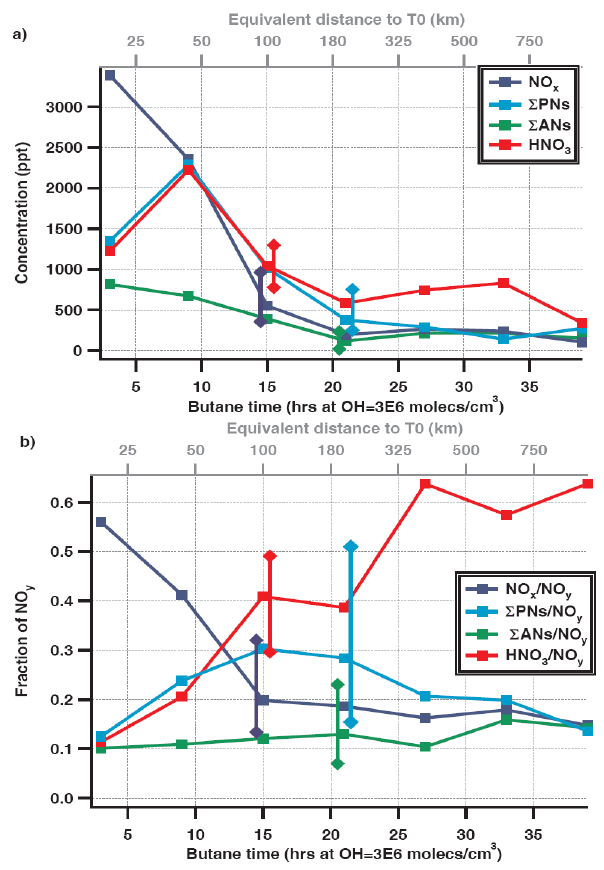
Figure 4a) Observed concentrations of the components of NO y as a function of 708 Fig. 4. (a) Observed concentrations of the components of NO y as a function of photochemical age. Error bars show the 1 σ variation photochemical age. Error bars show the 1 σ variation in the data. 4b) Observed fraction of 709 in the data. (b) Observed fraction of NO y comprised of each of the NO y comprised of each of the NO y reservoirs as a function of photochemical age. Again, 710 NO y reservoirs as a function of photochemical age. Again, error error bars show the variation at 1 σ . 711 bars show the variation at 1 σ 712